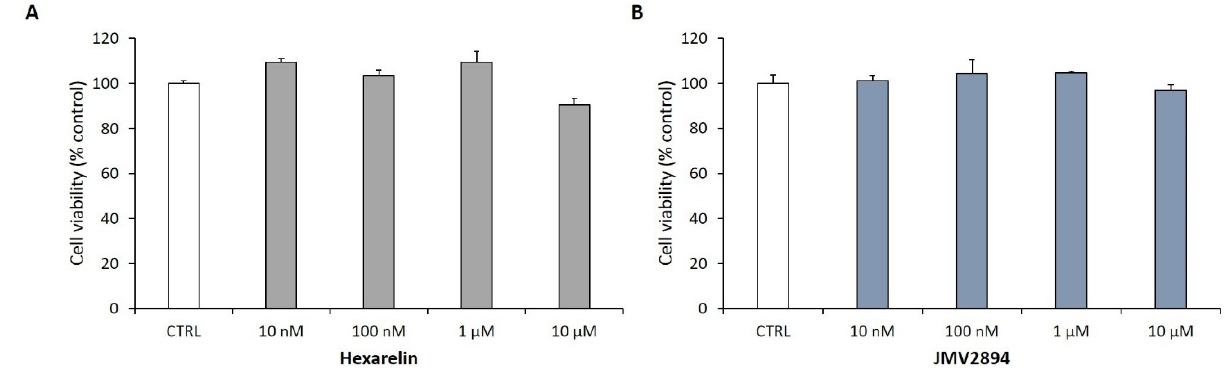
Figure 2. Effects of GHS on the viability of SH-SY5Y SOD1 G93A cells. SH-SY5Y SOD1 G93A cells were plated at a density of 40,000 cells/well in 96-well plates. Once confluence was reached, they were treated with increasing concentrations of ( A ) hexarelin or ( B ) JMV2894 (10 nM–10 µM) for 24 h. At the end of the treatment, cell viability was assessed by MTT assay. The results are expressed as mean ± SEM of data obtained from 3 independent experiments ( n =